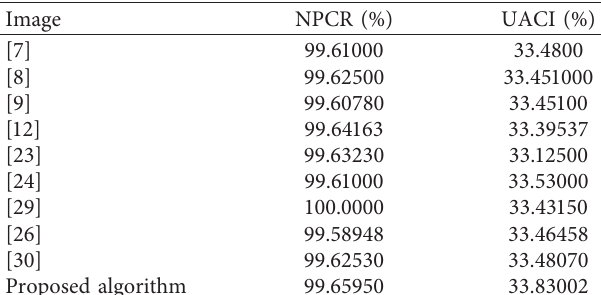
Table 9: Comparative study of NPCR and UACI tests for the Lena